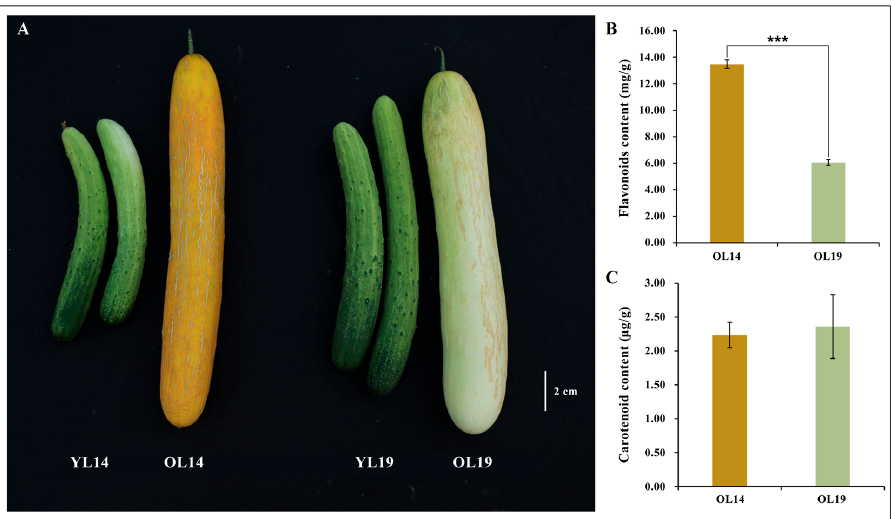
Figure 1. The phenotypic characters and determination of flavonoids and carotenoids in cucumber materials. ( A ) Pheno- type of fruit in YL14, OL14, YL19 and OL19. Scale bar = 2 cm. Flavonoids content ( B ) and carotenoid content ( C ) in cucum- ber fruit at maturity. Bars are means of three replicates ± SEM. *** p < 0.001.